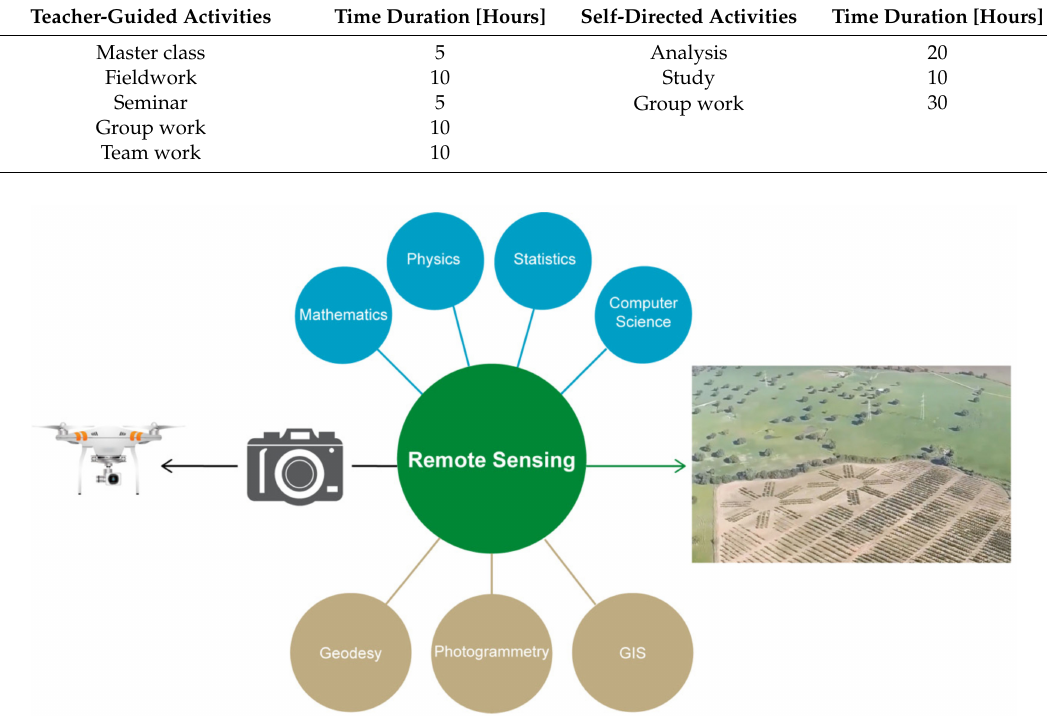
Figure 2. Knowledge areas involved in UAV-RS to transform a collection of UAV-images into useful